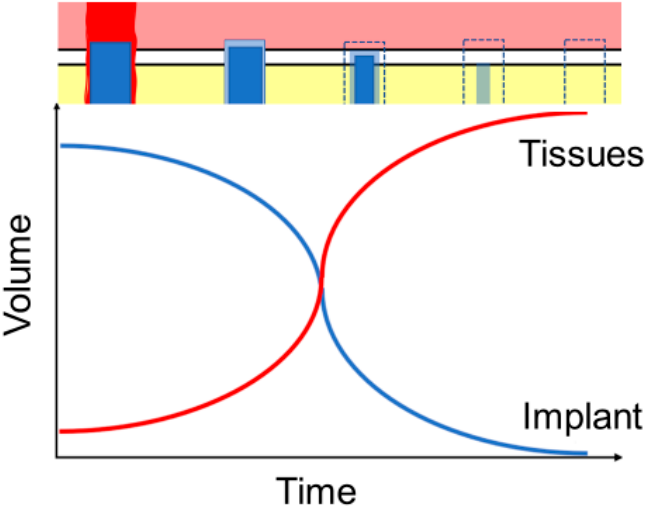
Figure 2. Ideal implant degradation and tissue regrowth dynamics against time. The rate of implant degradation has to be balanced to correspond to tissue regeneration, so the lost implant volume and mechanical strength are compensated by new tissue until the implant is completely degraded and absorbed.